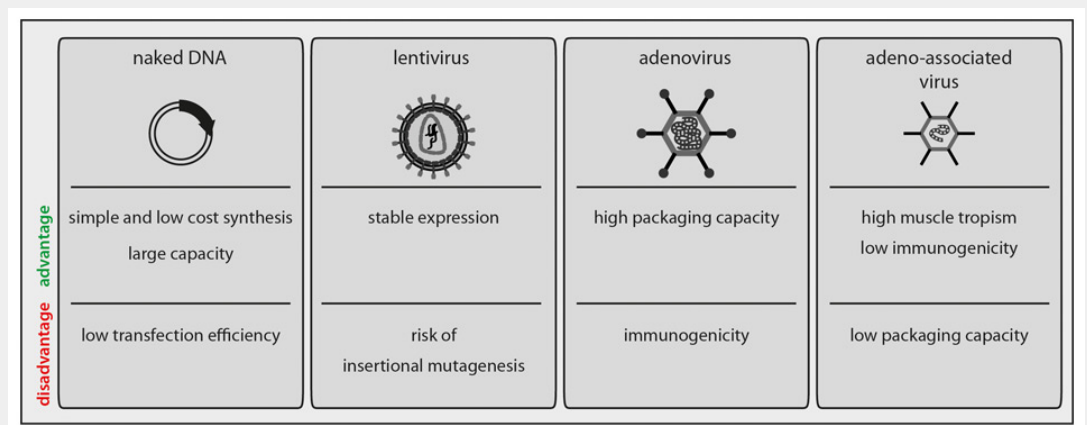
Figure 3 Different gene therapy strategies used in muscular dystrophies. In muscular dystrophies, gene therapy is used to deliver genetic material into the host and finally target the diseased muscle tissue to correct the genetic defect. In most cases, the transferred DNA encodes for the protein missing due to a mutation. Gene transfer can be mediated by different strategies and vectors. The methods differ in their transduction efficiency, packaging capacity, risk of immunogenicity or oncogene activation by genome